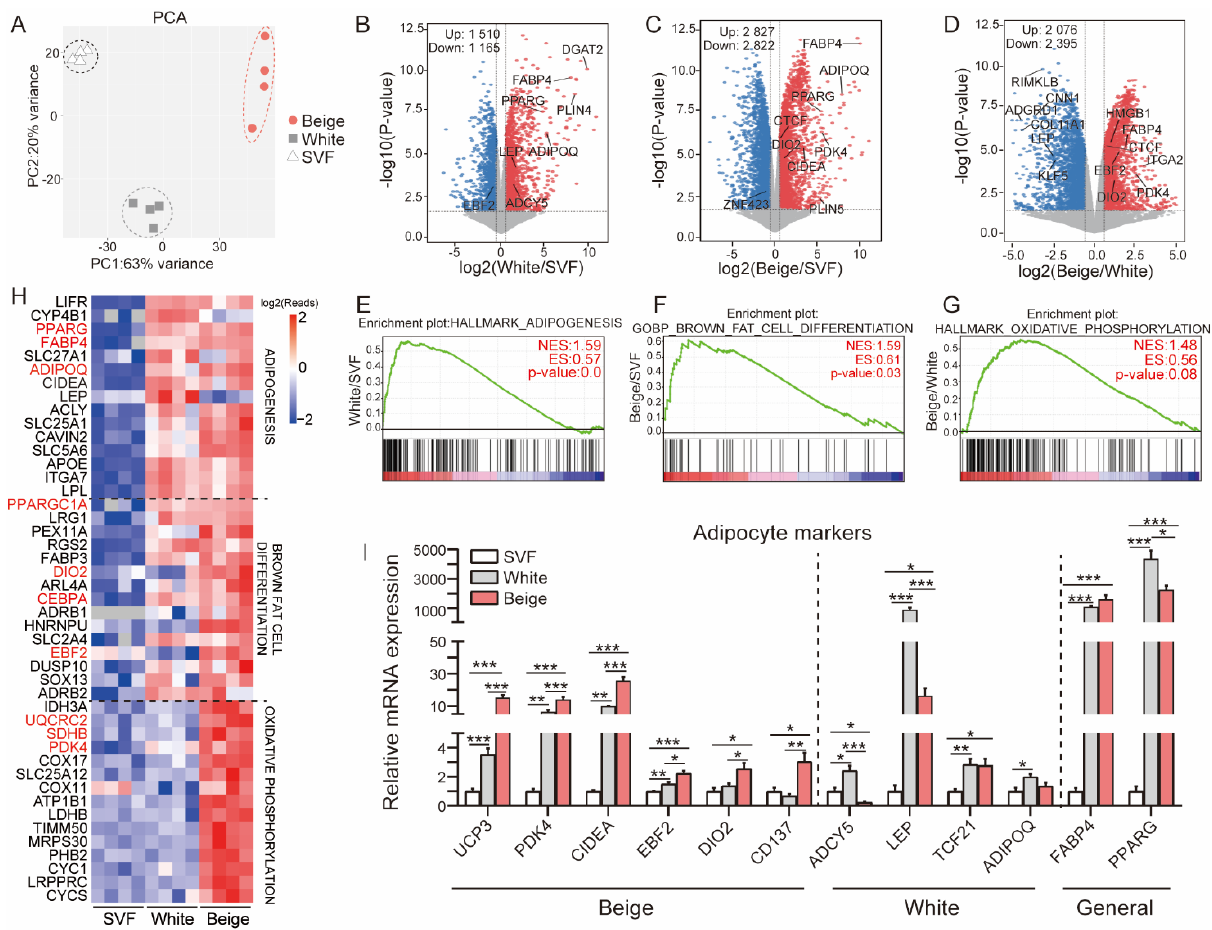
Figure 2. Distinct transcriptional profiles of porcine white and beige adipocytes. ( A ) Principal component analysis (PCA) plots representing SVFs, and white and beige adipocytes based on transcriptome data ( n = 4 for each group). ( B – D ) Volcano plots showing a global overview of the gene expression profiles of SVF cells and white and beige adipocytes; well-known adipocyte marker genes are highlighted. Up: upregulated genes; Down: downregulated genes. ( E – G ) Gene set enrichment analysis (GSEA) of the RNA-seq data. GSEA showing the enriched pathways in white adipocytes compared with SVF cells ( E ). Comparison of a signature from beige adipocytes to genes upregulated in SVF cells as described; the GSEA results showed enrichment for brown fat cell differentiation ( F ).